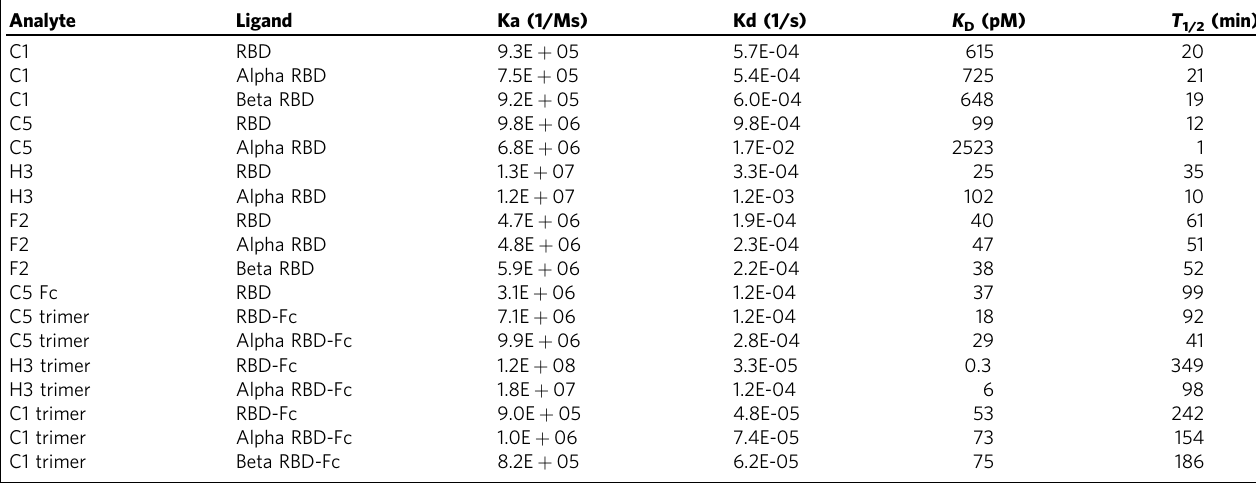
Table 1 Summary of nanobody binding kinetics. Analyte